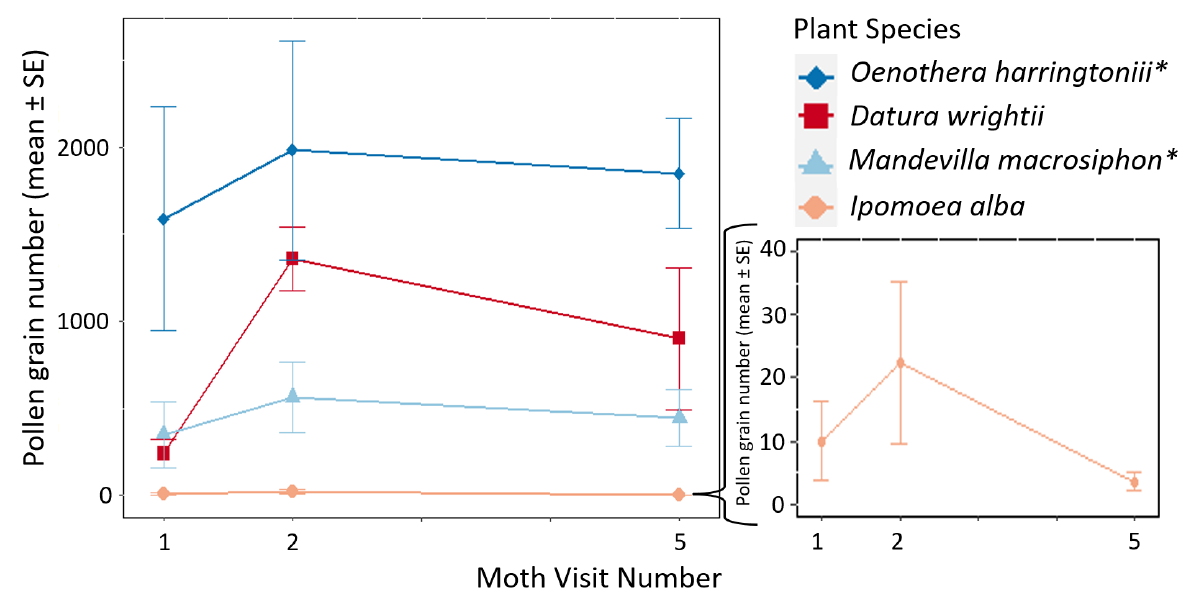
Figure 3. Accumulation of pollen on the proboscises of Manduca sexta moths by four plant species after 1, 2, or 5 successive floral visits. Due to the smaller number of pollen grains accumulated by moths visiting I. alba , data for this species is presented on both the main graph and the expansion below the legend. Plant species represented with blue and marked with an * had sticky pollen adhesion